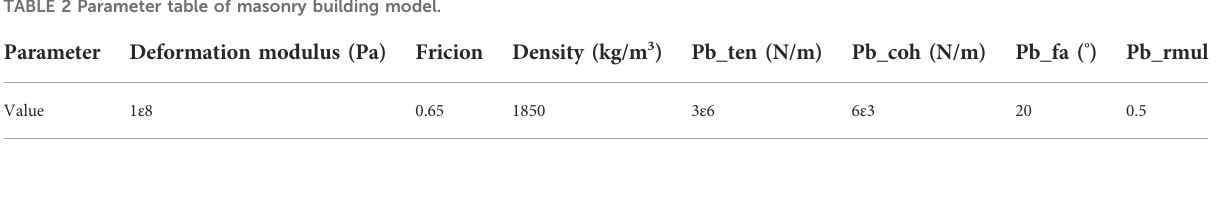
TABLE 2 Parameter table of masonry building